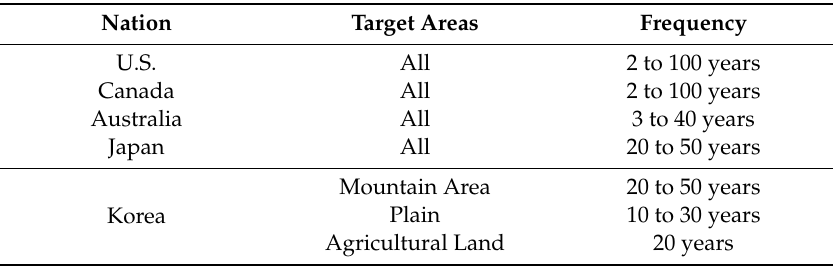
Table 2. Frequency for drainage by